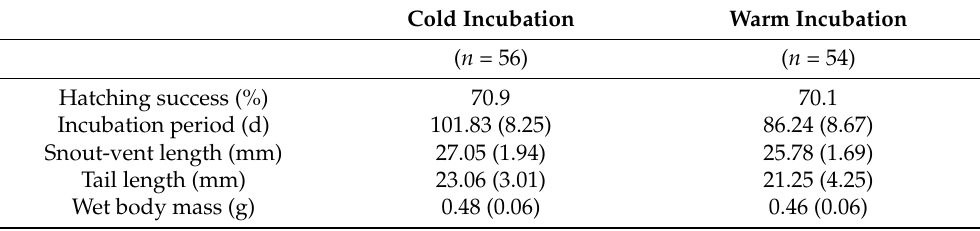
Table 1. The effect of cold versus warm incubation treatment on egg hatching success, incubation period, and hatchling snout-vent length, tail length and wet body mass. Standard deviations of means are shown in parentheses. Cold Incubation Warm Incubation ( n = 56) ( n =